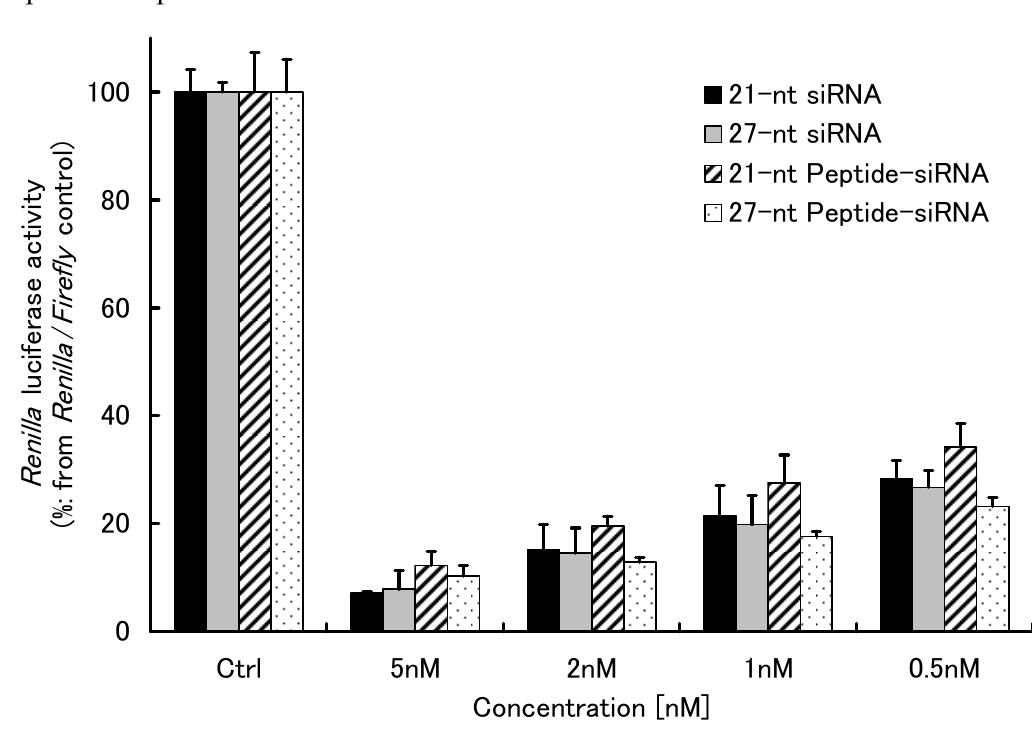
Figure 3. Comparative study of RNAi efficacy of Peptide-siRNAs and nonmodified siRNAs. The Peptide-siRNAs and nonmodified siRNAs (0.5, 1, 2, and 5 nM each) were transfected by LF2000 to HeLa cells, and controls were given only PBS( − ). RNAi efficacies of the Peptide-siRNAs and nonmodified siRNAs were evaluated to detect the luminescence of Renilla luciferase activity, which was normalized by the luminescence of Firefly luciferase activity, after 48 h incubation. The mean and SD values are from three independent